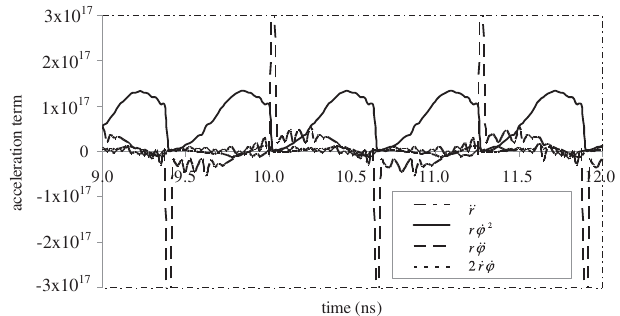
FIG. 4. Acceleration terms for a launch phase of (cid:1) 45 degrees where the radius is calculated from the center of the electron orbit.